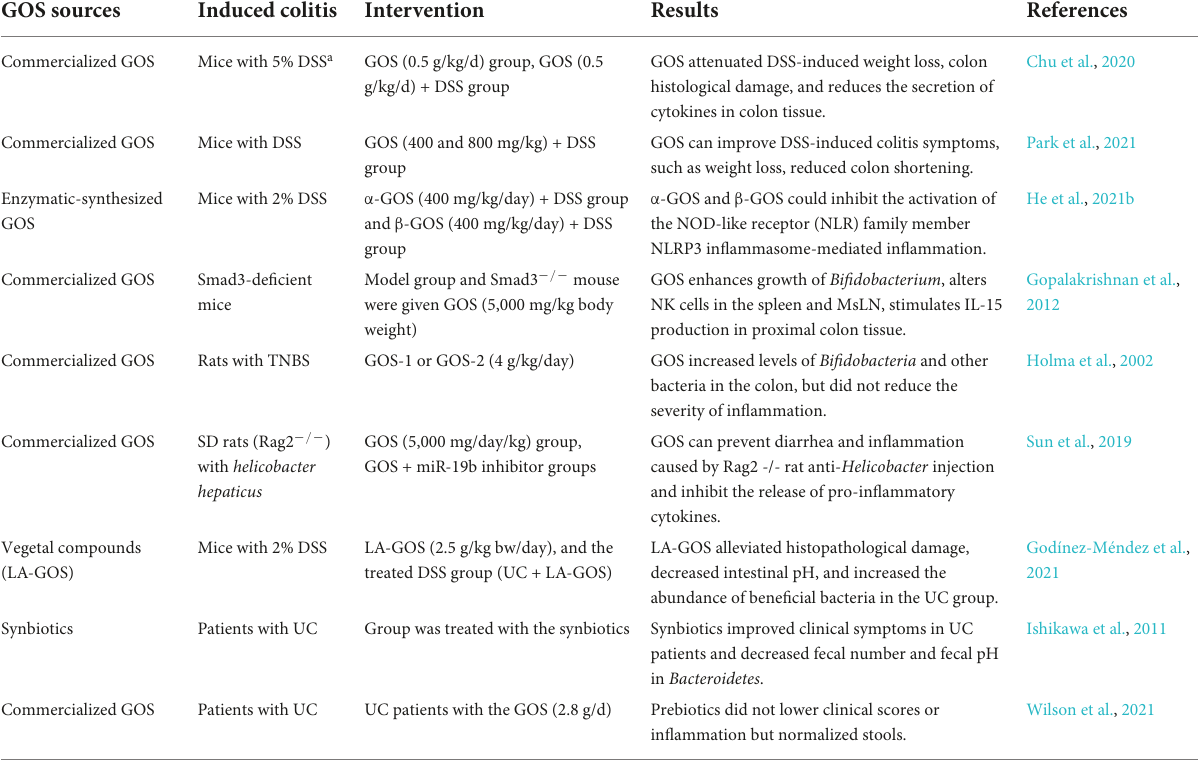
TABLE 1 Summarize the experimental and clinical research results of GOS in the treatment of